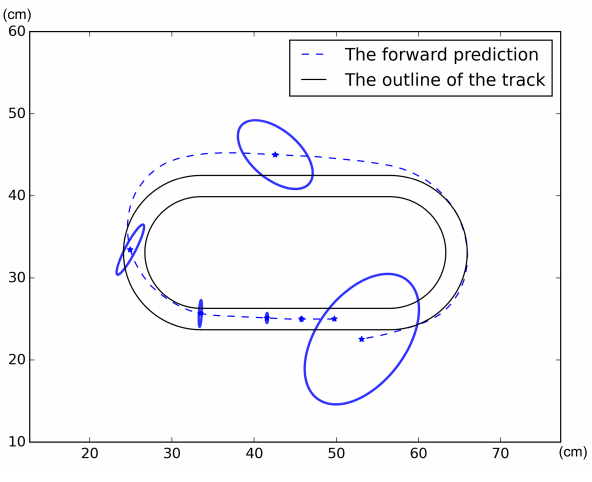
Figure 10. Position prediction.